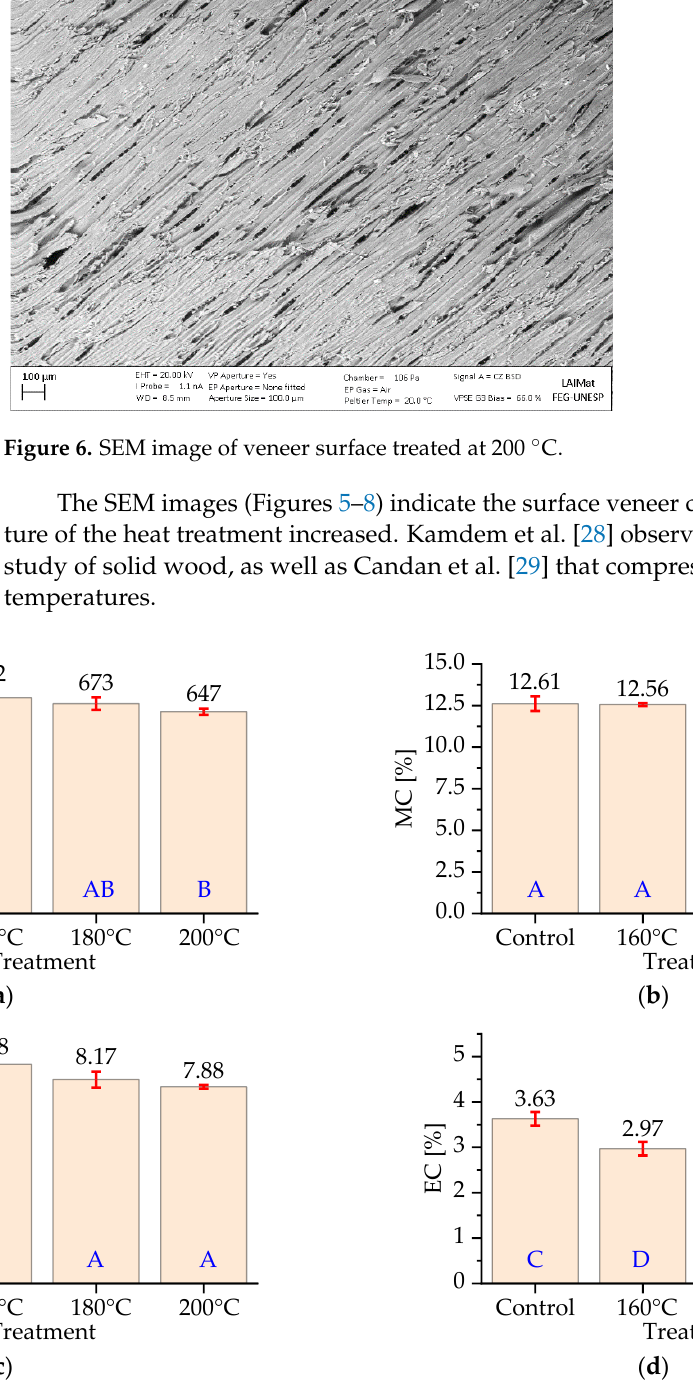
Figure 7. Physical properties of plywood produced with heat treated veneers: specific gravity ( a ), moisture content ( b ), swelling in thickness ( c ) and total extractive content ( d ). Same letters in col- umns implies that there was no statistical difference with 95% of confidence.